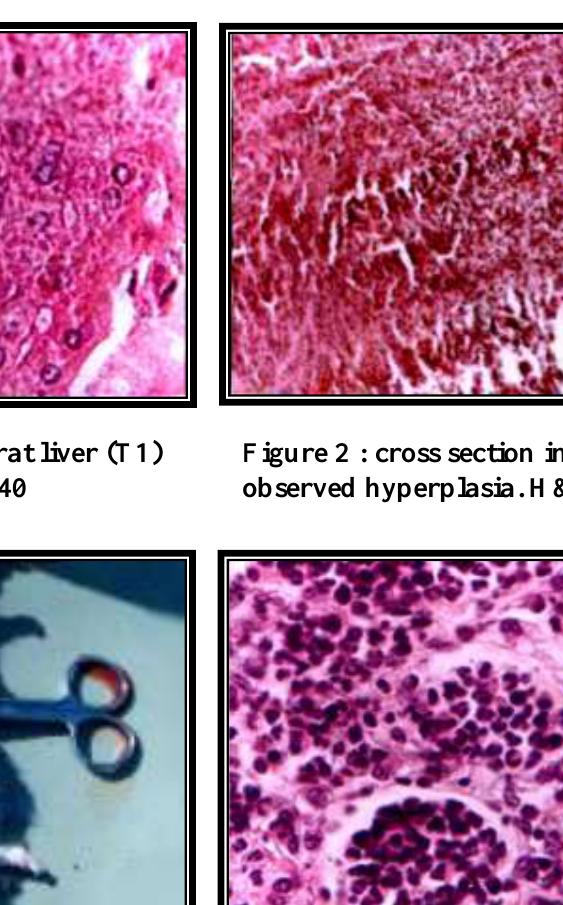
Figure 3 : Abdominal sub coetaneous fibroma in rat